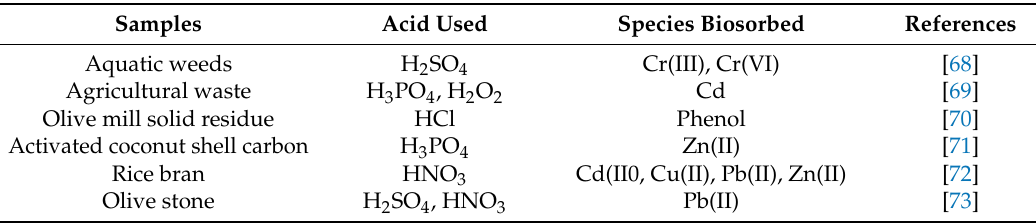
Table 2. Acid treated carbons as